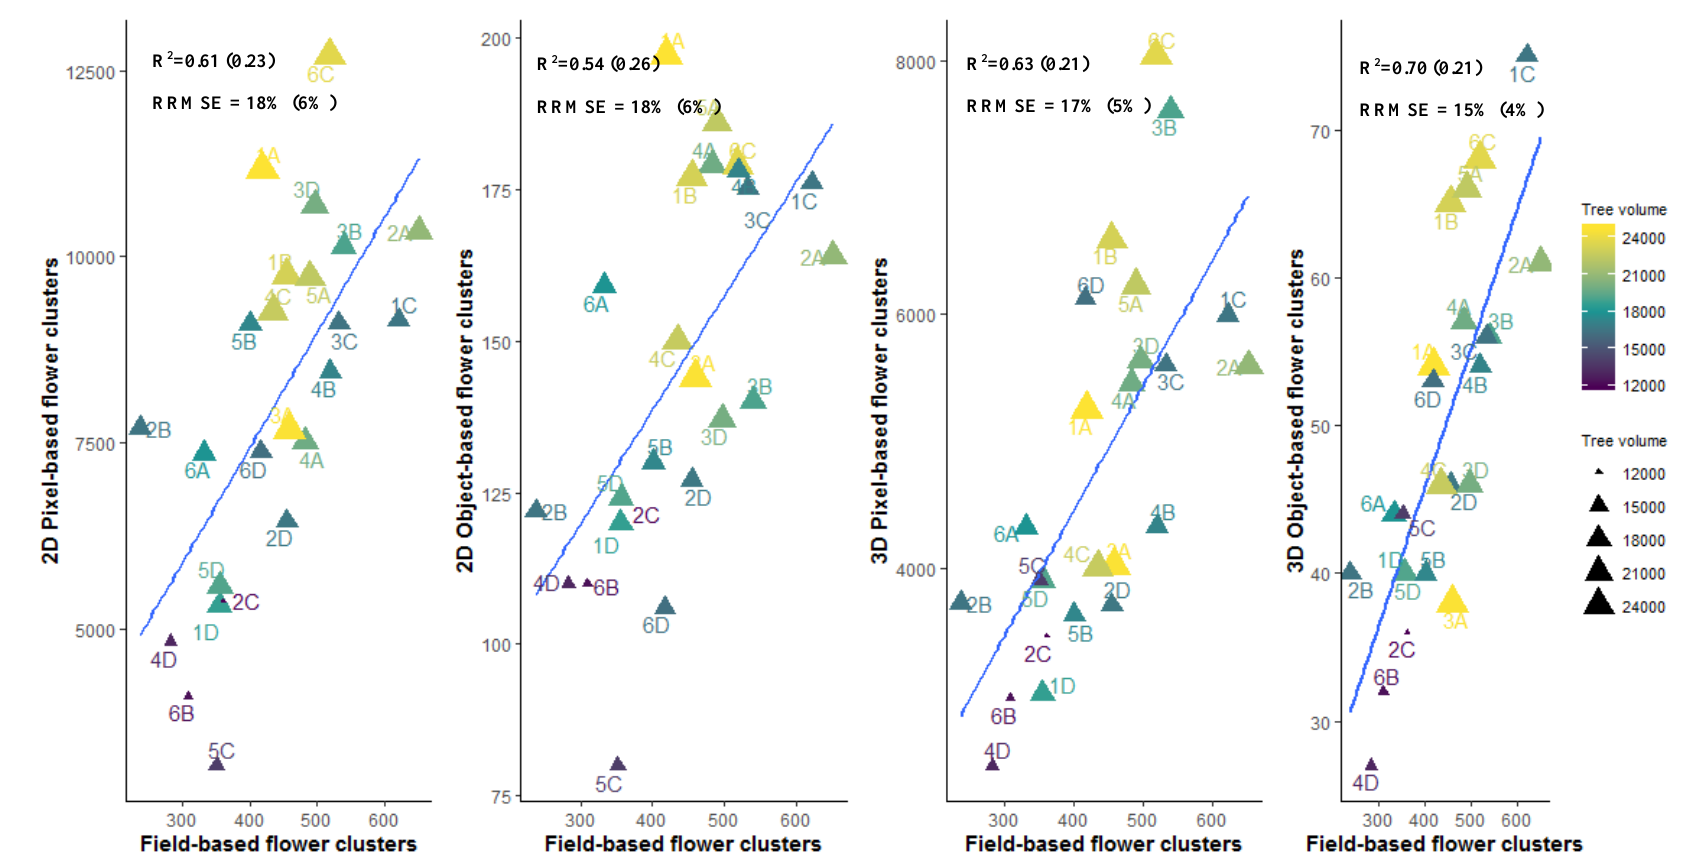
Figure 5. Correlation plots of Wimmertingen between the field-based flower clusters on plot level and the four retrieval models (i.e., 2D pixel-based flower clusters, 2D object-based flower clusters, 3D pixel-based flower clusters and 3D object-based flower clusters); the tree volume in cm 3 is visualized by the symbol size and color of the datapoints.